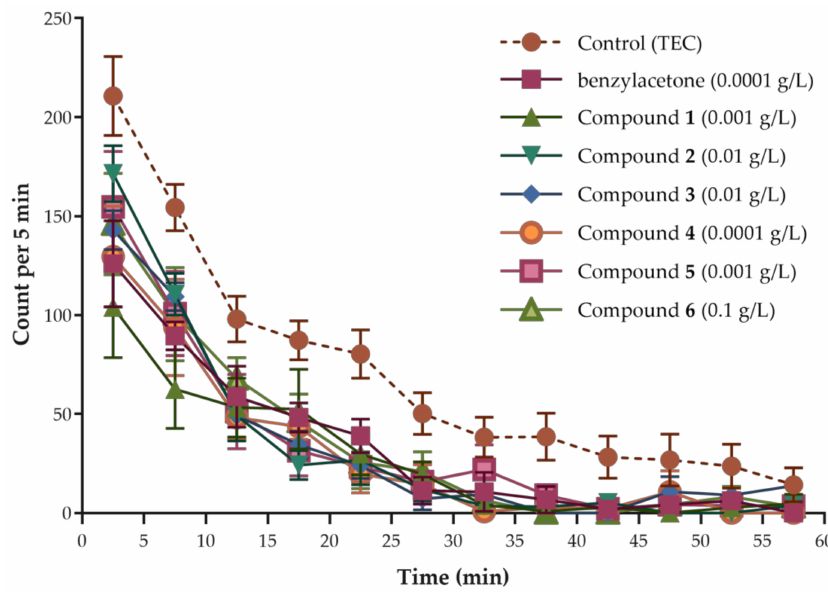
Figure 3. Locomotor transition activity of mice treated with the compounds investigated in the study at their respective most effective dose. Data are expressed as mean ± SEM ( n =